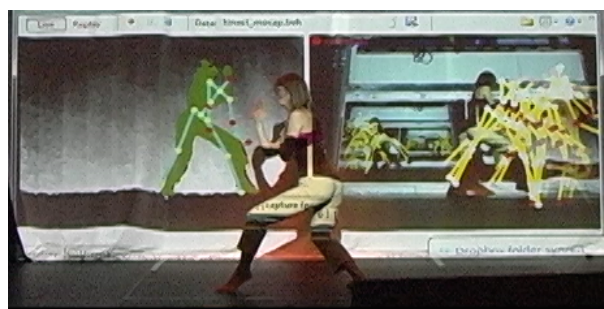
Figure 4. Choreographer Working with Kinect and Integrate Systems